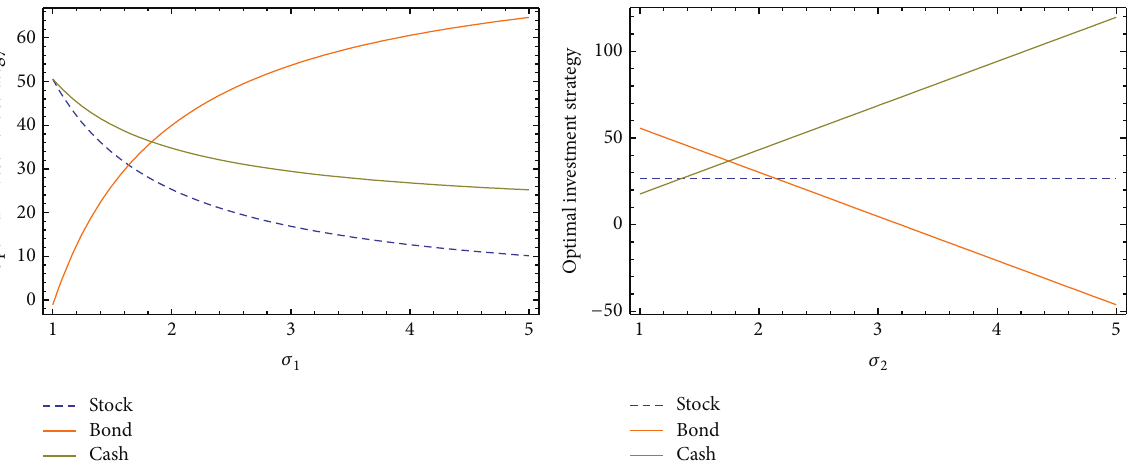
Figure 1: The effect of 𝜎 1 and 𝜎 2 on the optimal strategy.